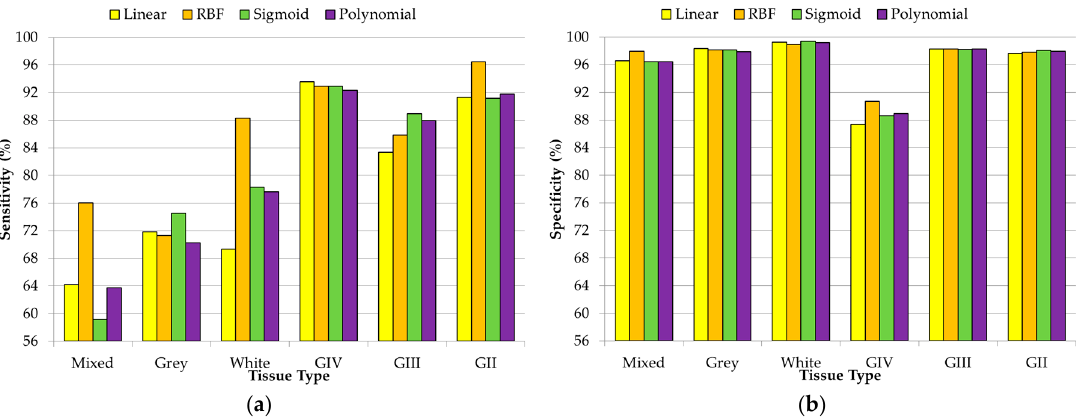
Figure 7. Average specificity ( a ) and sensitivity ( b ) results obtained (using the 10 × 5 cross-validation) with the optimal hyperparameters for each kernel type in the DL3 (normal mixed vs. grey matter vs. white matter vs. grade IV vs. grade III vs. grade II).